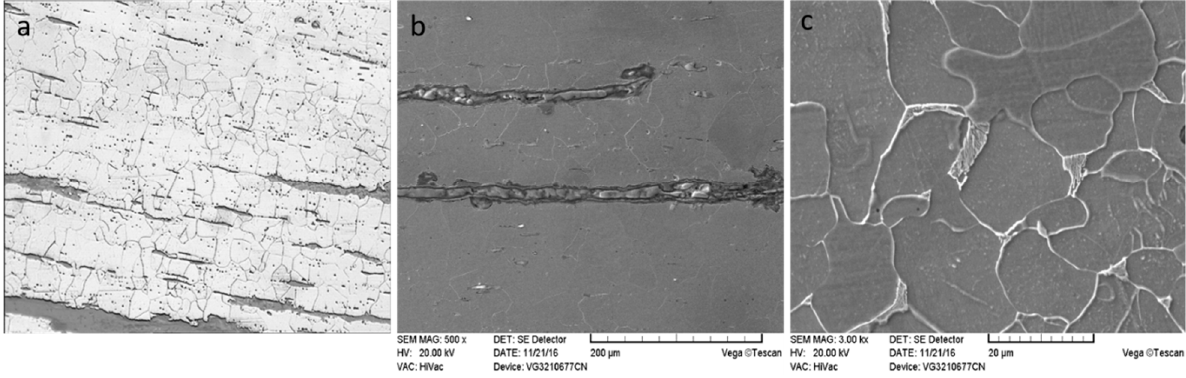
Figure 3. Corrosion morphology of (( a ) not erosion, ( b ) erosion, ( c ) pearlite structure characteristics).